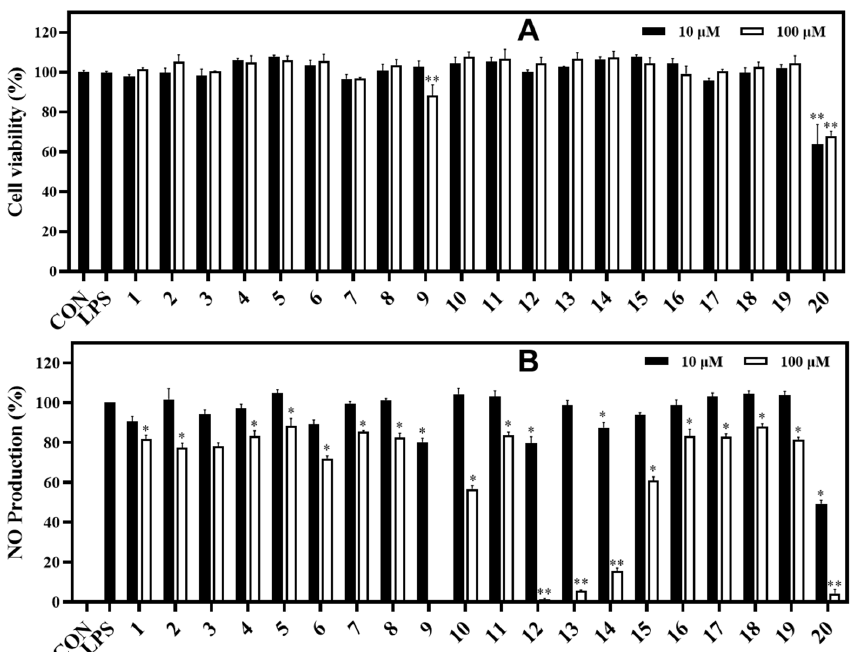
Figure 5. Cytotoxic e ff ects ( A ) and NO production inhibitory e ff ects ( B ) of isolated compounds ( 1 − 20 at 10 and 100 µM) in LPS-stimulated RAW264.7 cells. RAW264.7 cells were treated with compounds 1 − 20 (10 and 100 µM) for 1 h and stimulated with LPS (1 µg/mL) for 16 h. ( A ) The viability of cells was determined using an MTT assay. ( B ) The level of NO production in serum-free culture medium was measured. Both experiments were performed in triplicate. The data are represented as mean ± SD. * p < 0.05, ** p < 0.01, compared to the LPS-treated group. In the IL-8 assay, compounds 13 and 14 potently reduced LPS-induced IL-8 produc- tion in HT-29 cells with inhibition rates of 81.03% and 82.39%, respectively, compared to the control at the tested concentration of 100 µM. Under the same test conditions, com- pounds 8 , 9 , and 19 showed strong inhibition against IL-8 production with inhibition rates of 70.39%, 68.58%, and 72.59%, respectively. Compounds 1 − 4 , 6 , 7 , 10 − 12 , and 15 − 18 ex- hibited signi fi cant inhibition against IL-8 production at rates ranging from 64.98% to 32.35%. Compound 20 strongly inhibited IL-8 production at a concentration of 100 µM. However, compounds 11 and 20 also showed some toxic e ff ects when measuring cell via- bility (78.07% and 75.29%, respectively) of HT-29 cells. Whereas other compounds dis- played cell viability e ff ects ranging from 86.43% to 109.54% at both tested concentrations of 10 and 100 µM using the MTT assay (Figure 6).